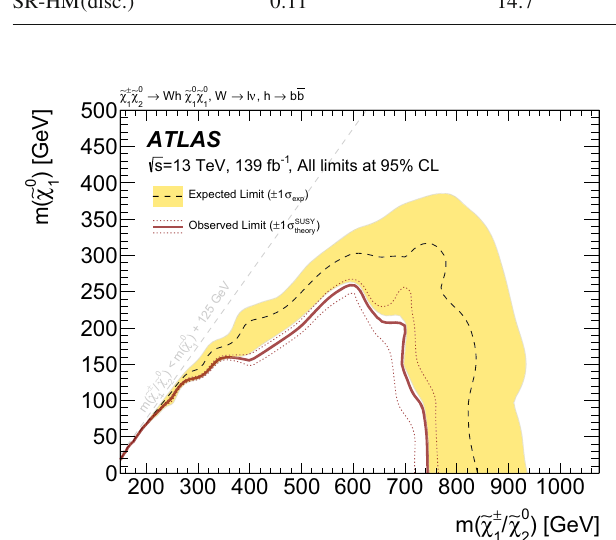
Fig. 6 Model-dependent exclusion contour at 95% CL on the produc- tionofacharginoandanext-to-lightestneutralino.Theobservedlimitis given by the solid line with the signal cross-section uncertainties shown by the dotted lines as indicated in the text. Expected limits are given by the dashed line with uncertainties shown by the shaded band